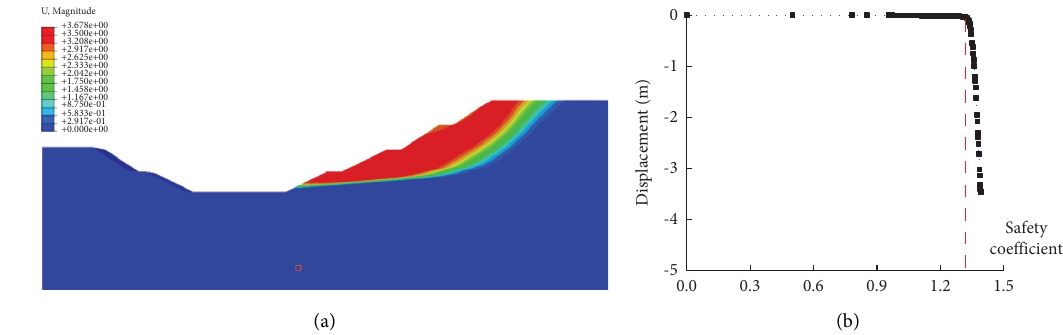
Figure 10: Displacement and safety factor under check condition. (a) Displacement nephogram; (b) stability safety